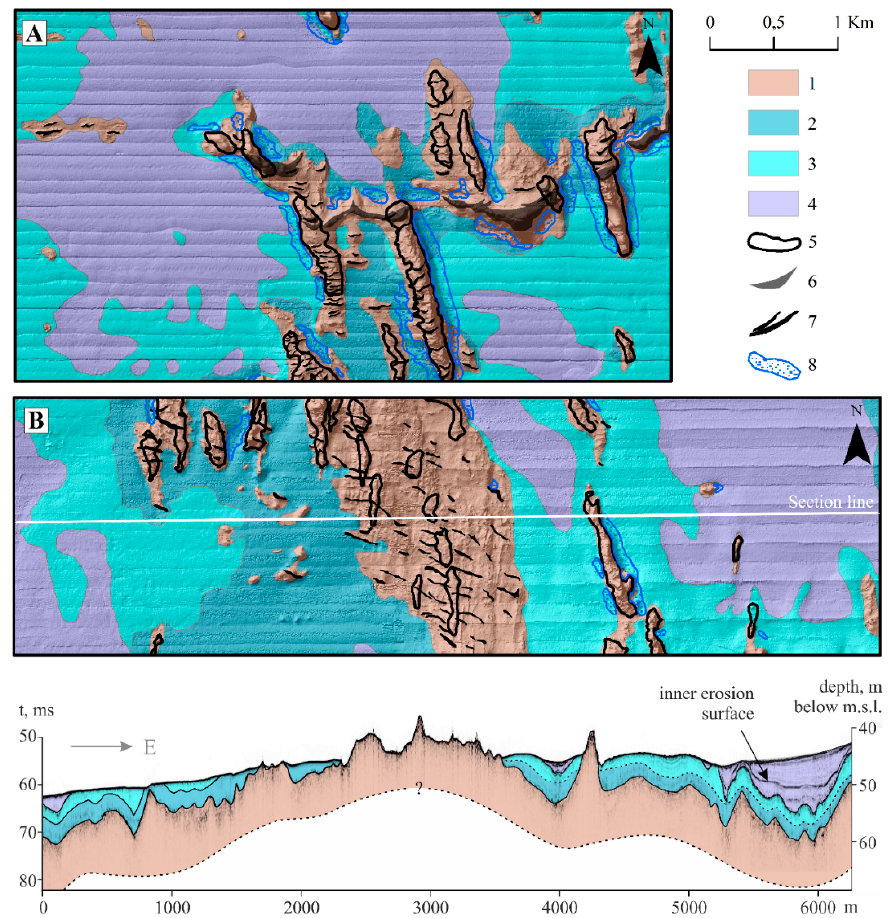
Figure 11. Distribution of Quaternary sedimentary units and seabed morphology based on geological interpretation of SBP and MBES data; ( A ) Vyborg Bay key area; ( B ) Moschny Island key area; ( C ) W–E cross-section. Sedimentary units (see explanation in panel A) consist of 1 = seafloor exposures of Late Pleistocene till with unconformable surface; 2 = seafloor exposures of Late Pleistocene varved glacio-lacustrine clays with unconformable surface; 3 = seafloor exposures of unconformable to disconformable Late Pleistocene homogenous (non-laminated) glacio-lacustrine clays, 4 = sediment basin filled with Holocene marine silty-clayey muds. Interpreted geomorphological features consist of 5 = streamlined moraine ridges; 6 = end-moraine ridges; 7 = De Geer moraine; 8 = depressions formed as a result of contourite current action around exposed moraine ridges.